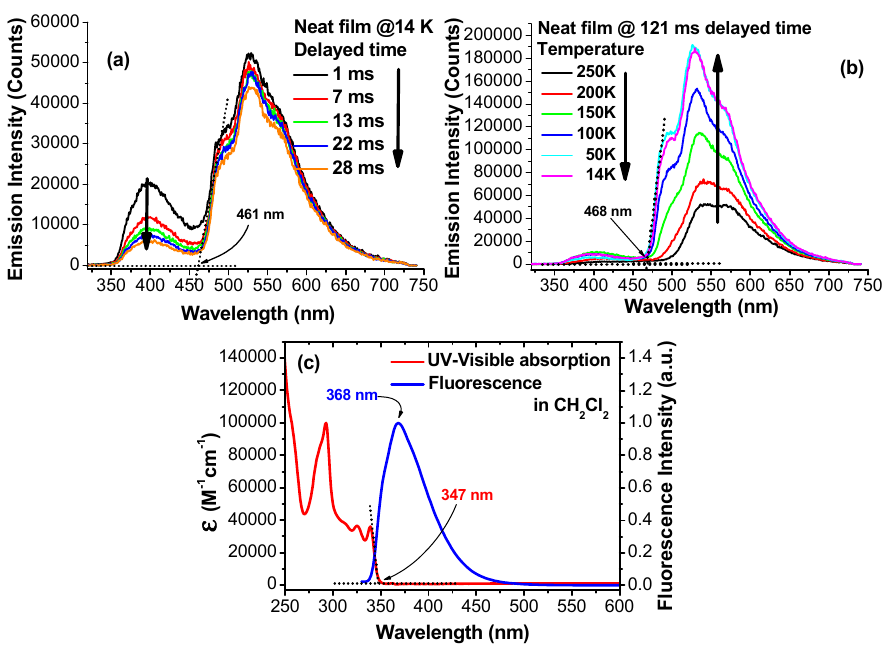
Figure 4. ( a )Variable time-gated PL spectra of SimCP3 thin film. ( b ) Variable temperature, 121 msec time-delayed PL spectra of SimCP3 thin film. ( c ) Room temperature absorption and PL spectra of SimCP3 in dichloromethane solution.